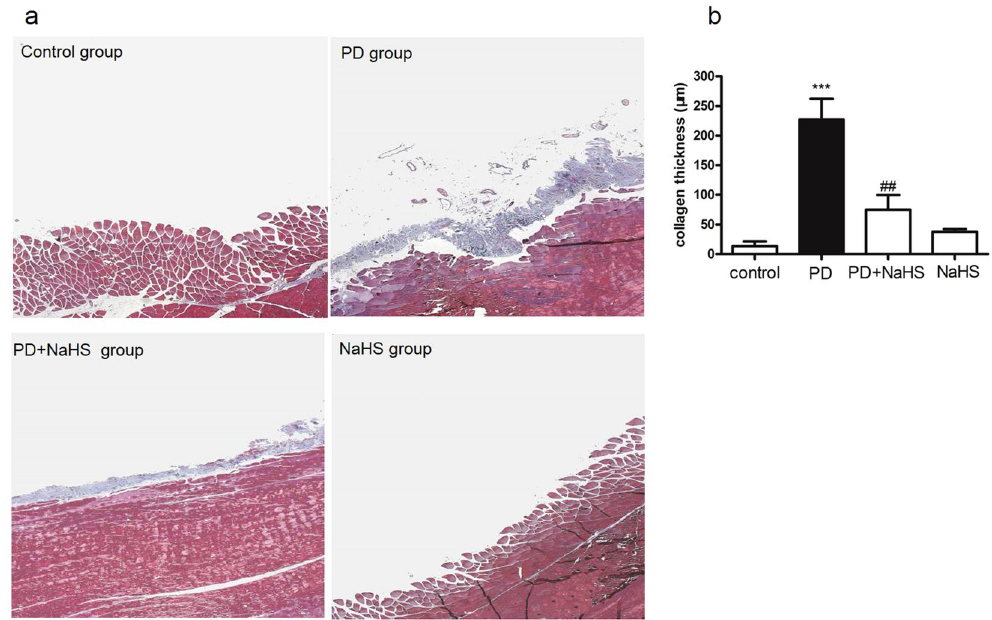
Figure 1. Masson-trichrome staining of rat peritoneal tissue. ( a ) On the 28th day, the fibrotic thickness of the rat peritoneum in the PD group was significantly increased compared with the control group. Administration of NaHS (56 µ g/kg/day) in the PD rats markedly reduced the deposition of collagen fibers. The thickness of collagen fibers (blue) of the NaHS group and the control group was comparable. Magnification × 200. ( b ) Quantitative analysis of the collagen thickness ( µ m) of the peritoneum. Data are presented as mean ± SD, n = 5.